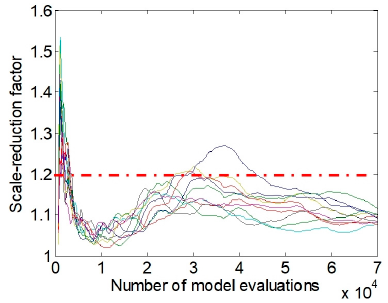
Figure 6. Evolution of the scale reduction factor for the estimation parameters.